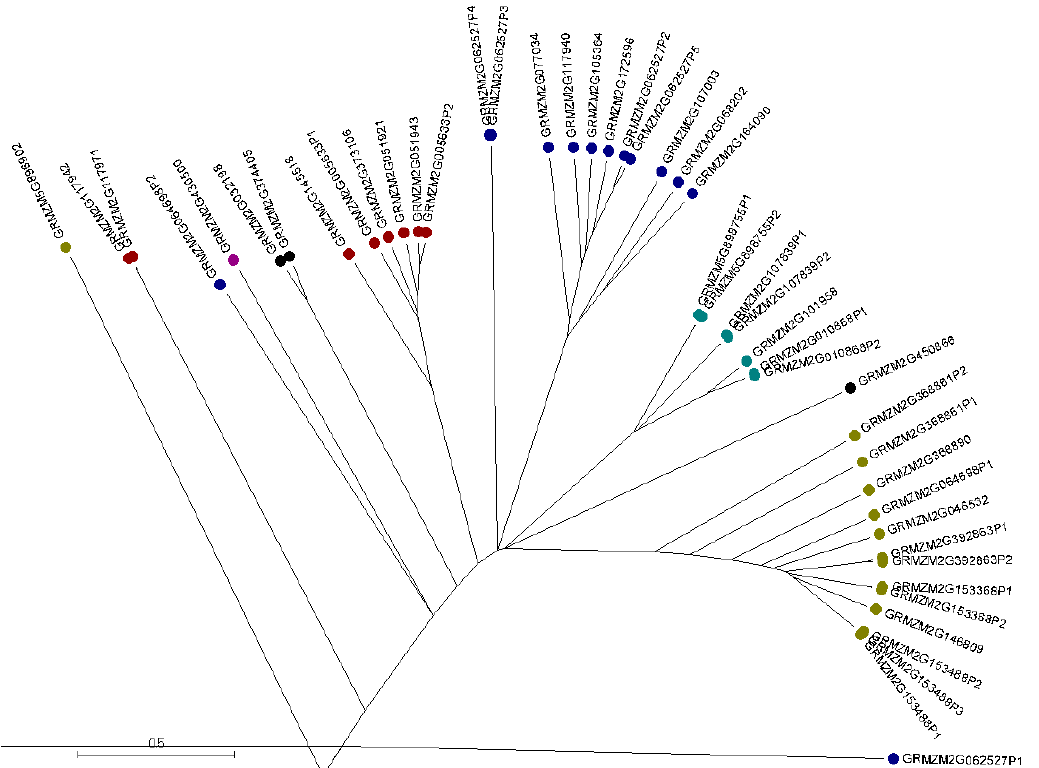
Figure 1. A phylogenetic tree of maize antimicrobial peptides. The forty-six identified maize AMPs are separated into 10 groups. Color coding indicates the corresponding AMP families with Hevein (red), Snakin (blue), Defensin (yellow-green), cyclotide (black), beta-barrelin (purple), and lipid transfer protein (LTP) (aqua). The phylogenetic tree is displayed with software MEGA